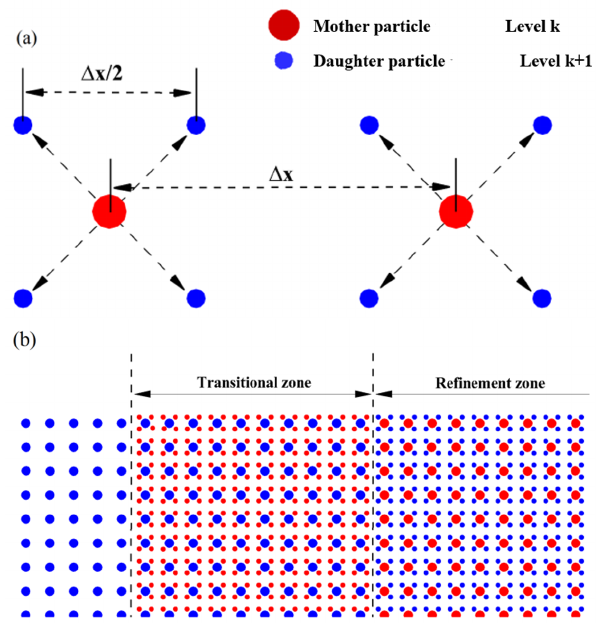
Figure 6. Schematic diagram of the APR technique [33,140]. ( a ) Particle splitting; ( b ) Particle refinement zone.